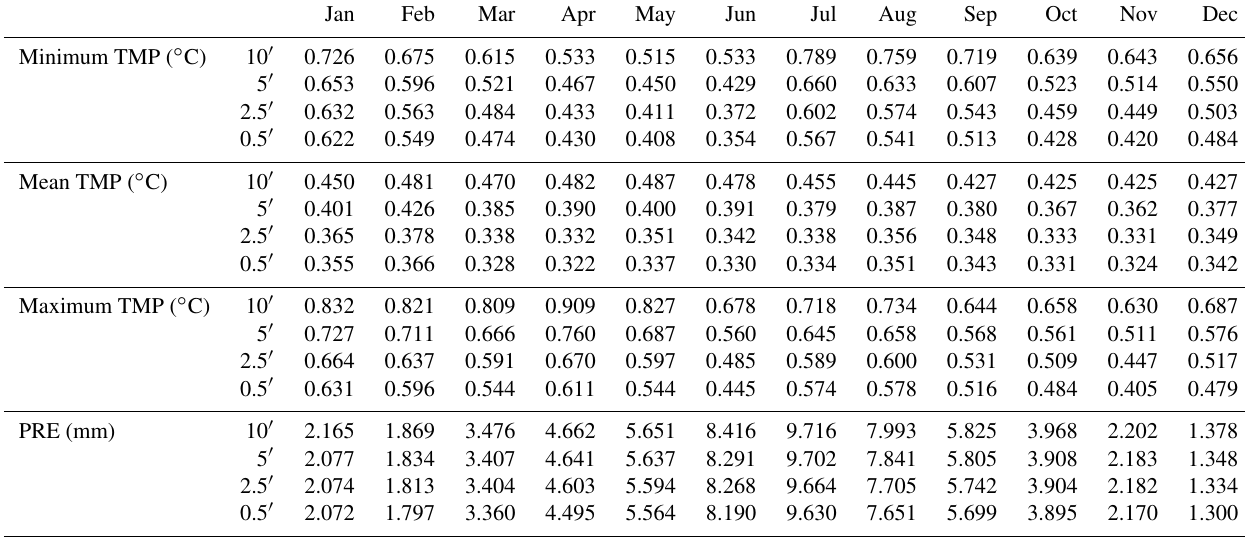
Table 1. Mean absolute errors between the observed and WorldClim climatology datasets at different spatial resolutions over independent weather stations for